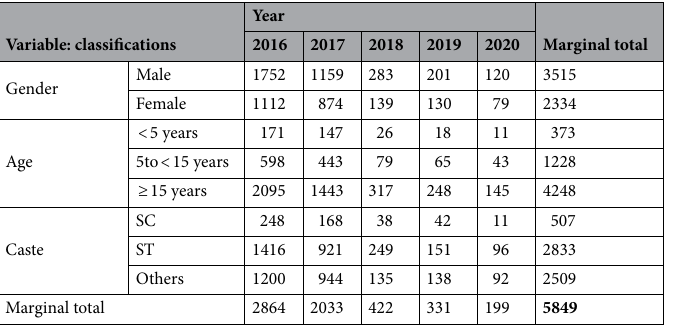
Table 1. Demographic breakdown of malaria cases in Purulia district from 2016 to 2020. Significance value is given in bold.